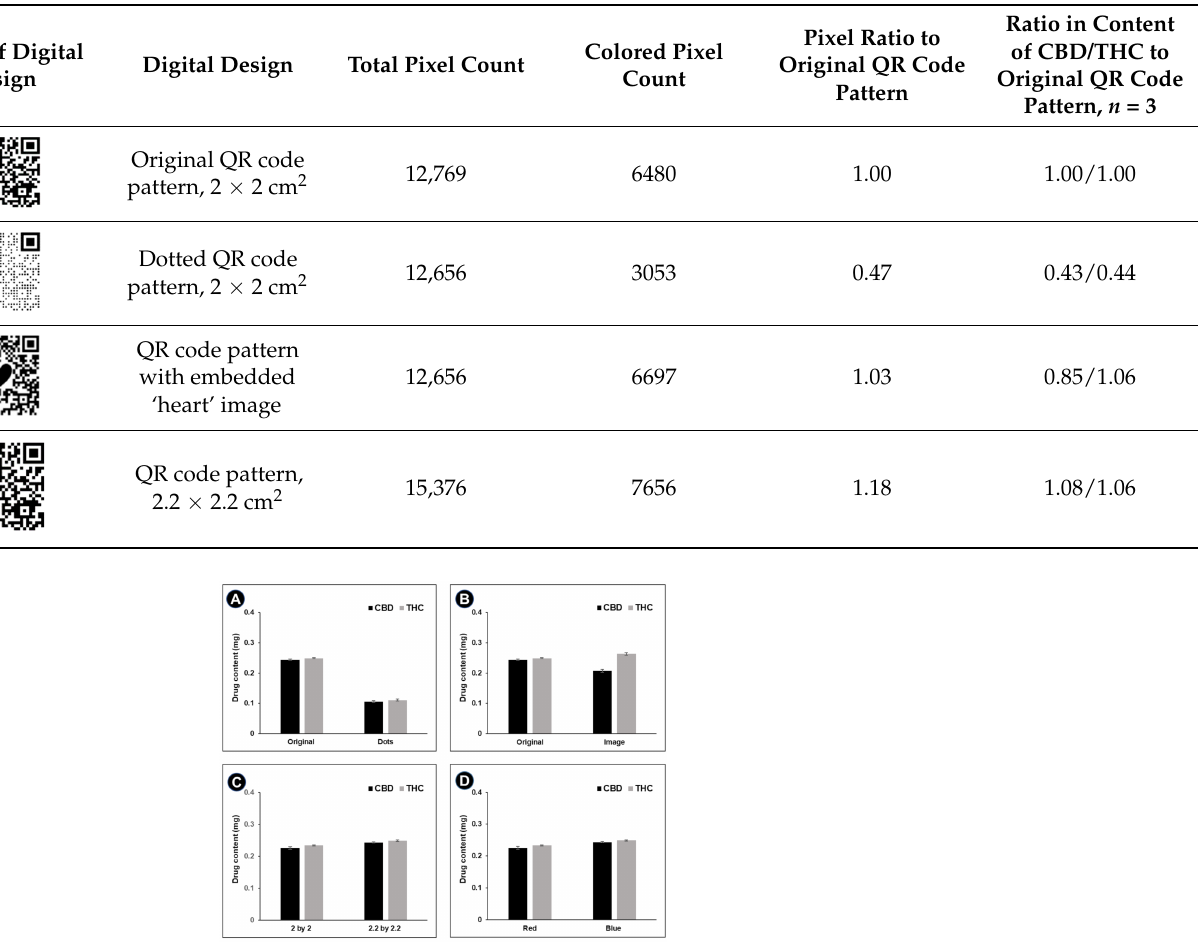
Figure 2. CBD and THC content of DEEP of ( A ) different patterns (original and dots (rasterized), printed in blue), ( B ) with and without the embedded image (original and ‘heart’ image, printed in blue), ( C ) different physical sizes (2 × 2 cm 2 and 2.2 × 2.2 cm 2 , printed in red) and ( D ) containing different coloring agents (printed in red and blue). Data are presented as average ± SD ( n = 3). All compared samples were significantly different ( p <